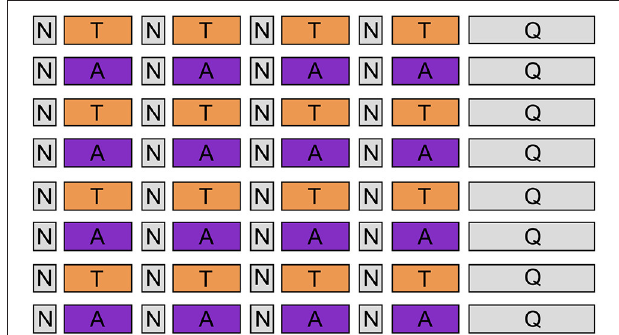
FIGURE 2 | Experimental design. Eight emotion-alternating blocks (orange boxes refer to “tenderness” condition, and purple boxes to “anguish”), each consisting of 4 emotion-inducing trials of 46 s, interleaved by 4 short neutral trials of 12 s. At the end of each block, participants had to fill out a self-assessment